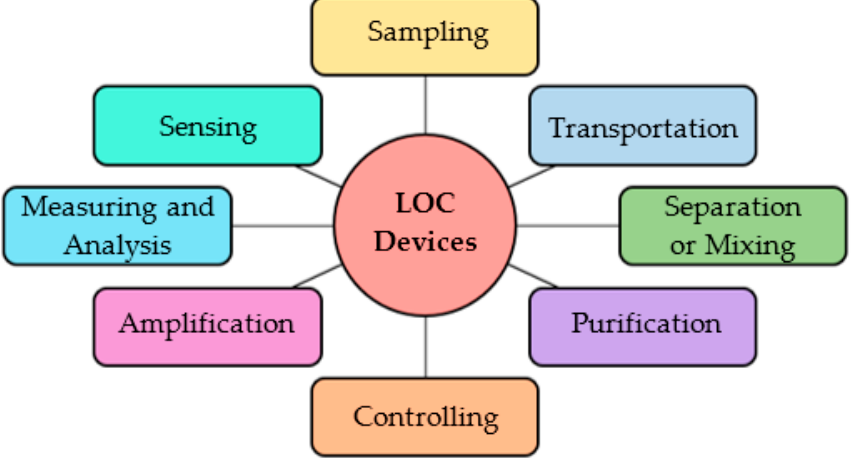
Figure 1. Key areas of LOC devices.